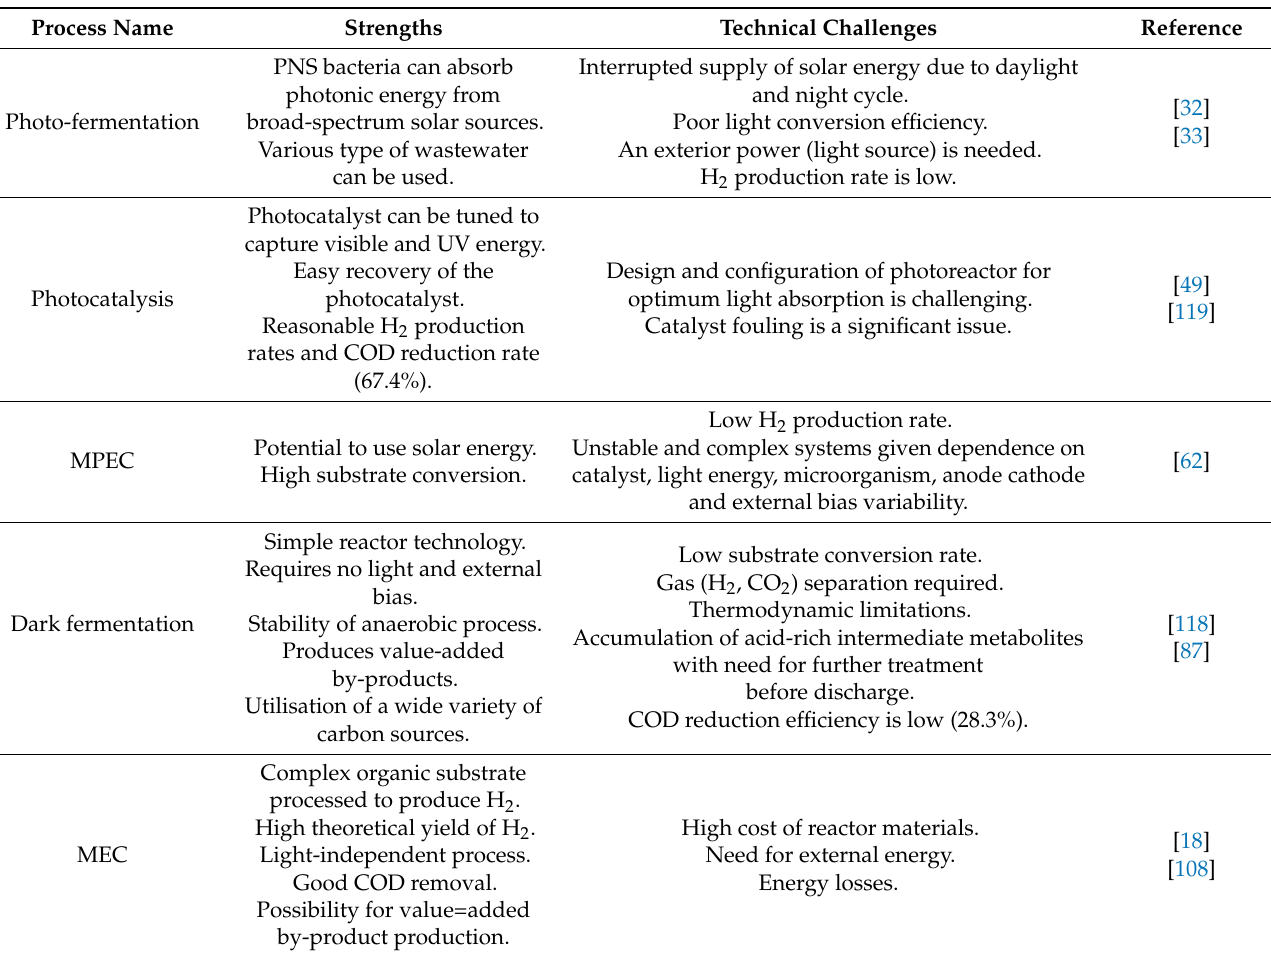
Table 12. Process comparison, strengths and technical